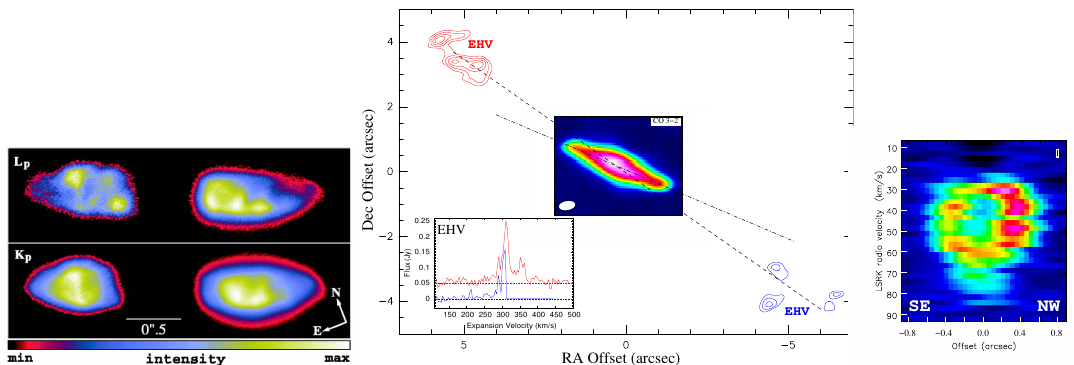
Figure 5. The water-fountain pre-PNe (PPN), IRAS16342 − 3814. ( left ) (adapted from [48]) False-color Adaptive Optics (AO) images of IRAS16342 − 3814 in the Lp and Kp bands. The right half of the image, covering the west lobe (which is significantly brighter than the east lobe), has been scaled differently in order to show structures in both lobes clearly. ( middle ) (adapted from [50]). Two high-velocity outflows seen in 12 CO emission— the “HVO” with an expansion speed of ∼ 260km s − 1 (colorscale), and the “EVO” (contours), with an expansion speed of ∼ 310km s − 1 and a different ejection axis than the HVO. Inset shows the spectrum of the red- and blue-shifted components of the EHVO, and the dashed (dash–dotted) line shows the axis of the EHVO (HVO). ( right ) (adapted from [50]) position-velocity cut along the major axis of the central ring structure.